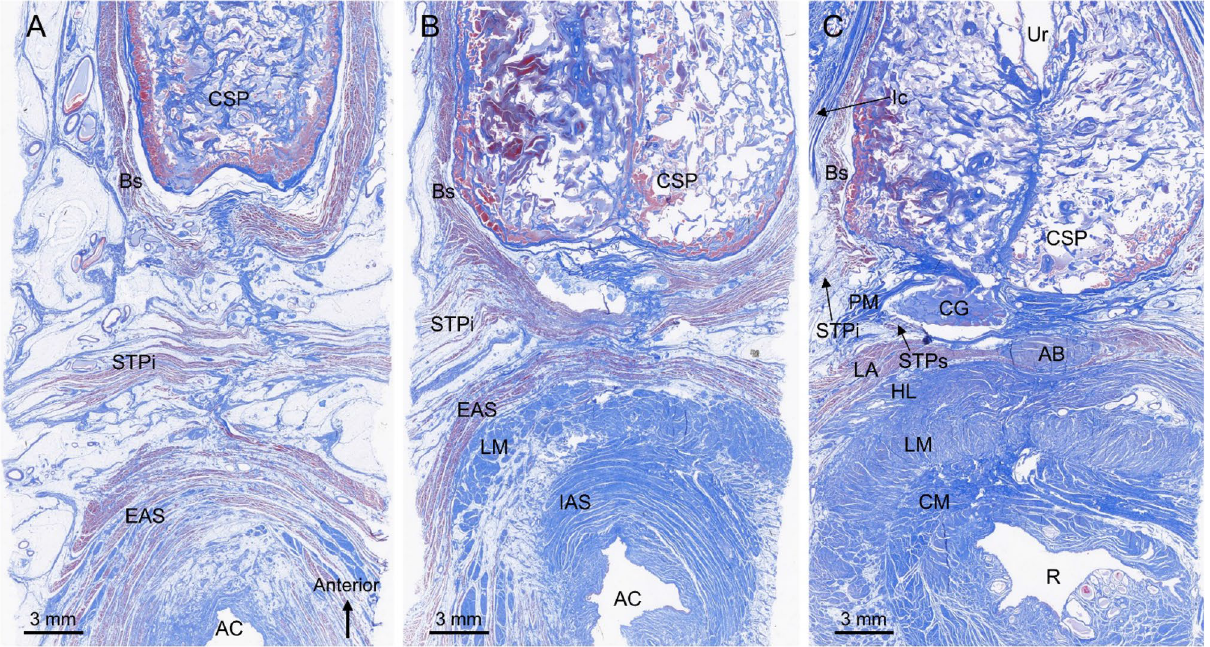
Figure 3. Transverse histological sections of the male perineum stained with Masson’s trichrome. ( A ) A superficial section in which the Bs, STPi, and EAS were observed. The STPi ran transversely between the Bs and EAS. ( B ) The Sect. 8 mm from the superior side of panel A in which the STPi was slightly displaced anteriorly and merged with the Bs. ( C ) The Sect. 8 mm from the superior side of panel B in which the STPi was displaced further anteriorly and integrated with the Bs. The CG was observed posterior to the CSP. The muscle fibers of the STPs were partially visible lateral to the CG. AB anterior bundle of LM, AC anal canal, Bs bulbospongiosus, CG Cowper’s gland, CM circular muscle, CSP corpus spongiosum penis, EAS external anal sphincter, HL hiatal ligament, IAS internal anal sphincter, Ic ischiocavernosus, LA levator ani, LM longitudinal muscle, PM perineal membrane, R rectum, STP superficial transverse perineal muscle, STPi inferior bundle of STP, STPs superior bundle of STP, Ur urethra.